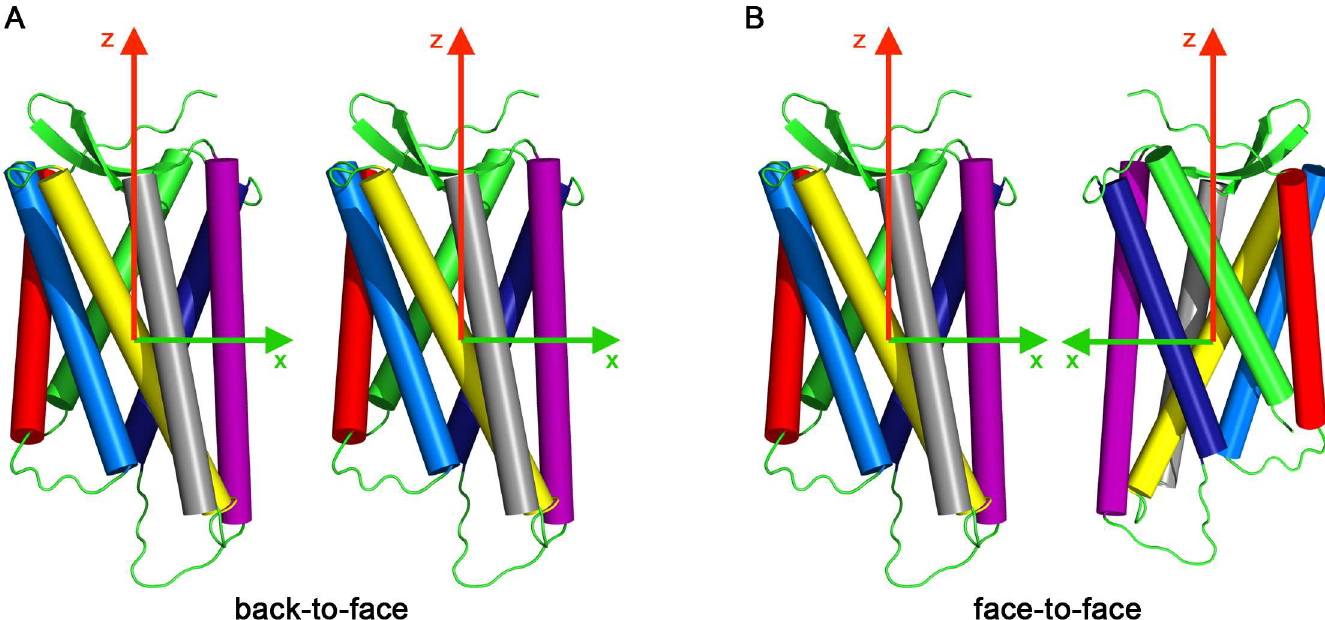
Fig 9. Relative orientation angles for TM5/TM1 or TM1/TM5 dimers a, corresponding to β = 0˚, χ = 180˚ or β = 180˚, χ = 0˚, respectively. The symmetric TM5,6/TM5,6 dimer b binds with β = 0˚ and χ =